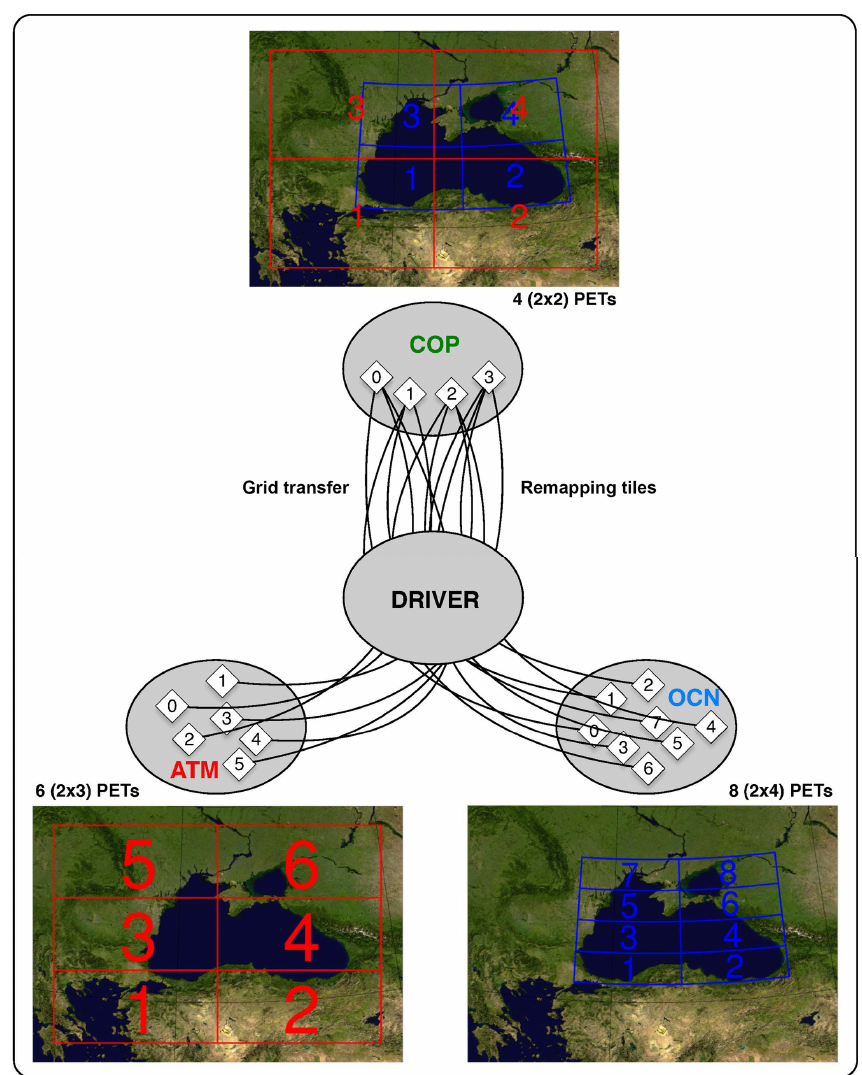
Figure 7. Two-component (atmosphere and ocean) representation of the grid transfer and remapping feature of the ESMF/NUOPC